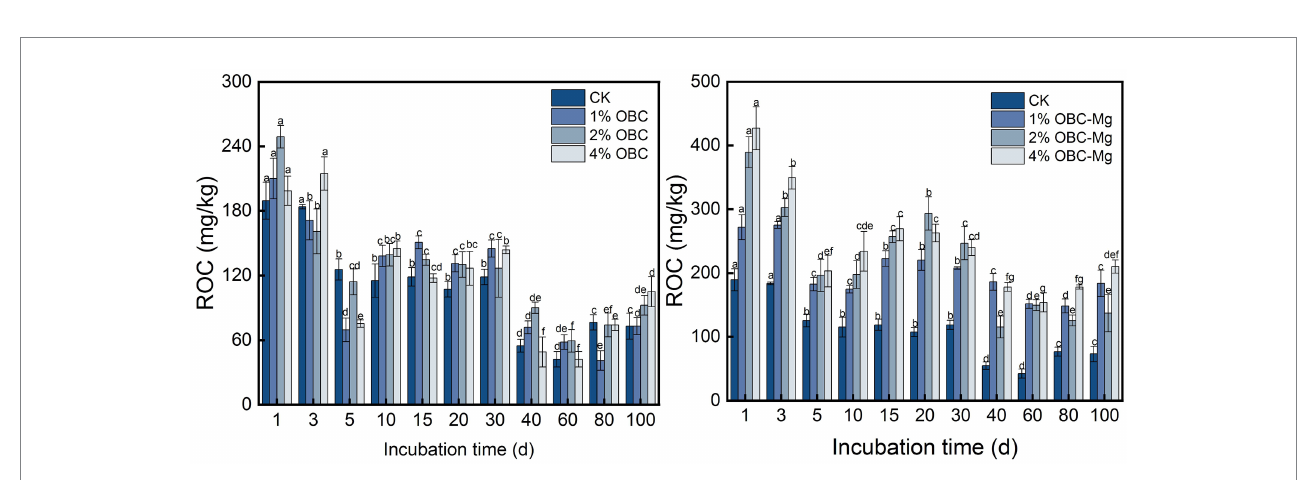
FIGURE 11 Changes in readily oxidized organic carbon (ROC) after the amendment of OBC and